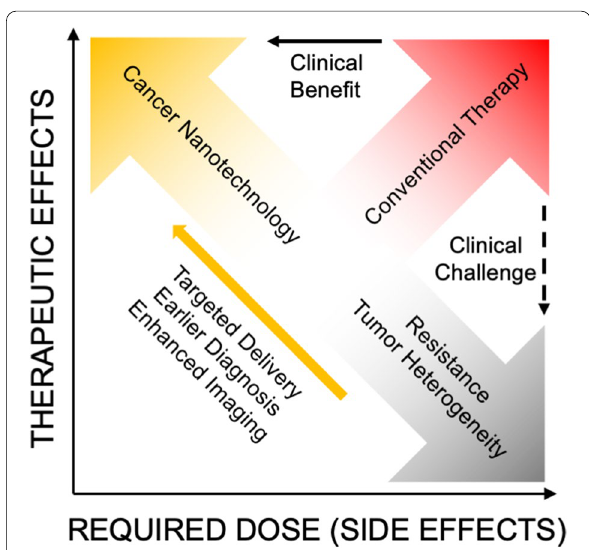
Fig. 6 Tumor heterogeneity and drug resistance are two major obstacles that conventional chemotherapy face. Nanotechnology can overcome these obstacles through multi-modal treatments and increase therapeutic efficacy while decreasing dosage by utilizing targeted delivery, stimuli-triggered release, and formulations to improve PK/PD profiles. Adapted with permission, [30] https:// doi. org/ 10. 1016/j. addr. 2015. 10.